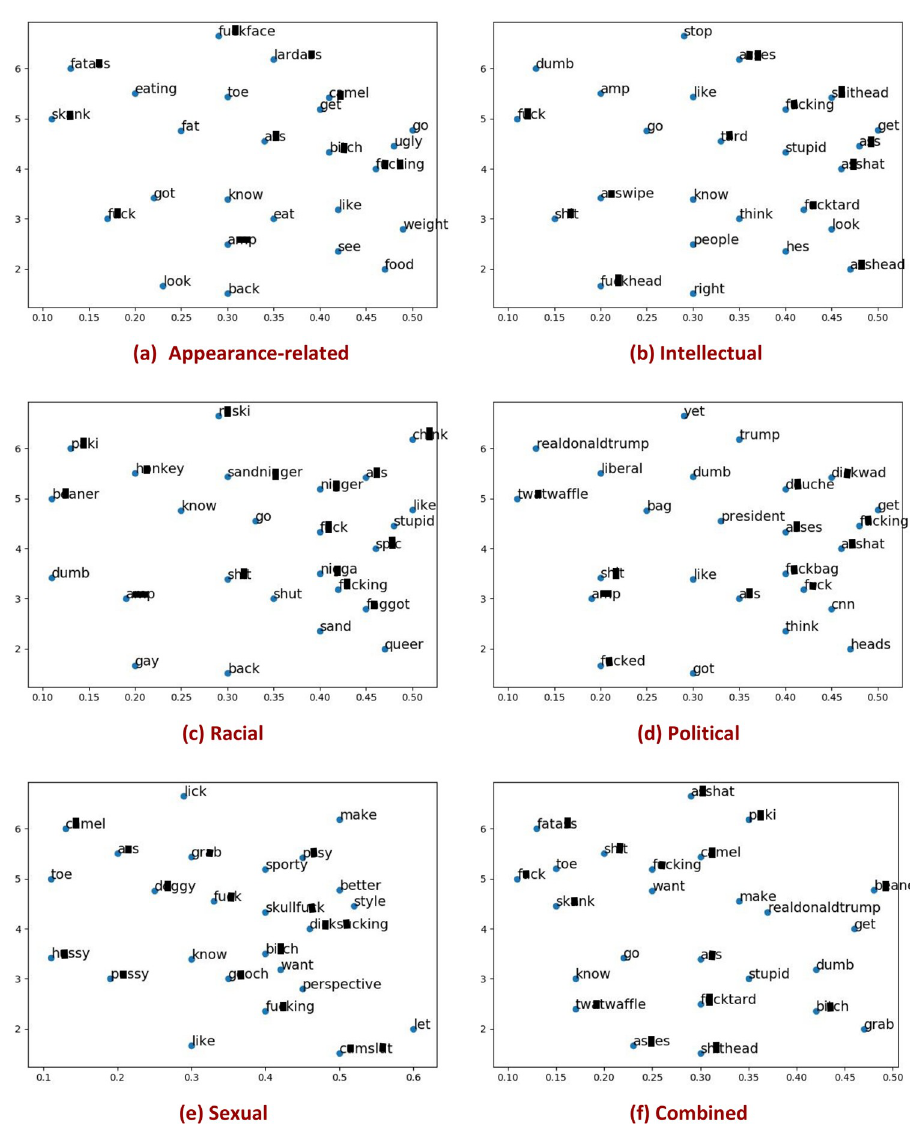
Fig 3. Top-25 frequent words within each harassing